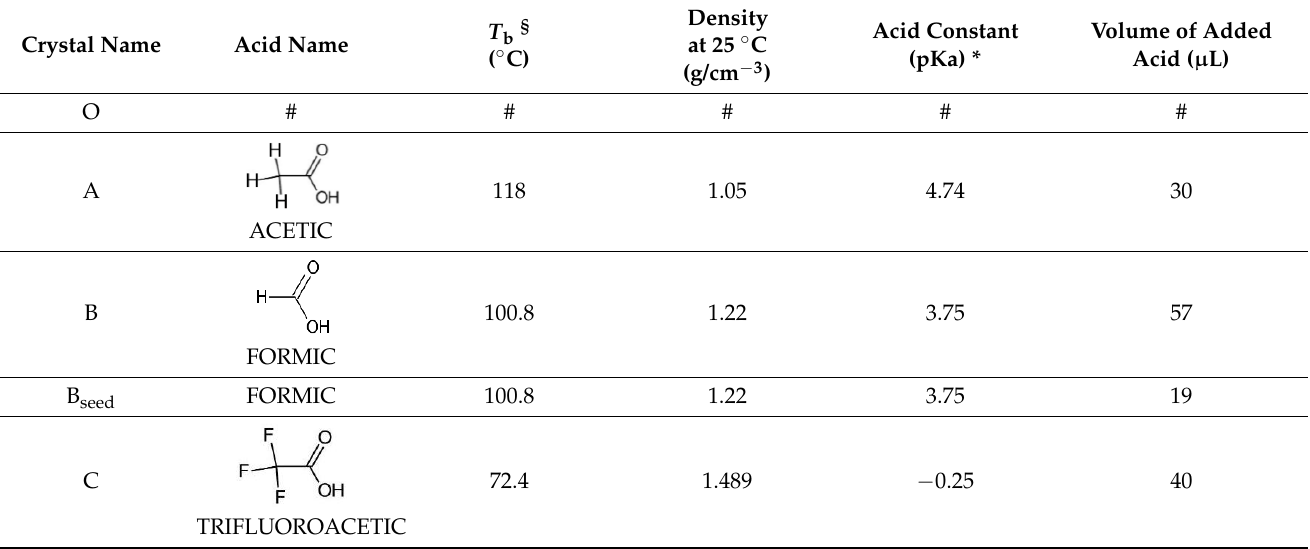
Table 3. Details of the crystallization method of CH 3 NH 3 PbI 3 (MAPI) in GBL with acid additives.